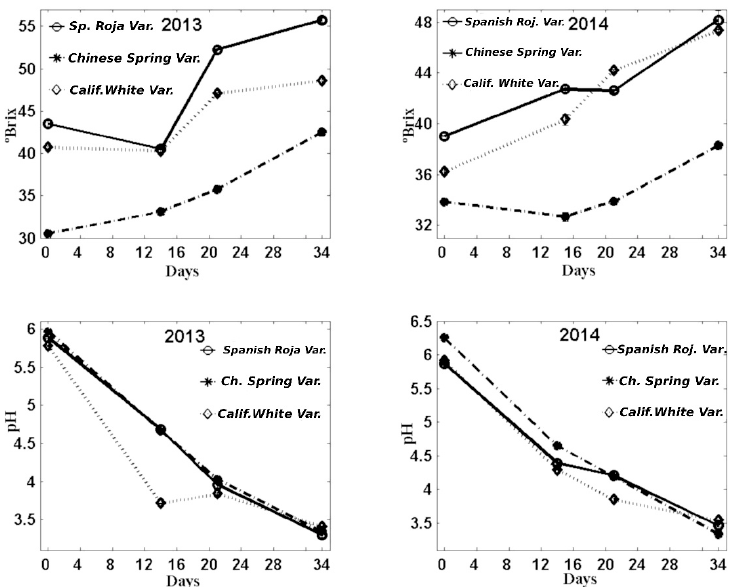
Figure 3. Evolution of °Brix ( top ) and pH ( bottom ) during black garlic manufacture with three varieties and two garlic types: one-year-old garlic (2013) and recently harvested garlic (2014).